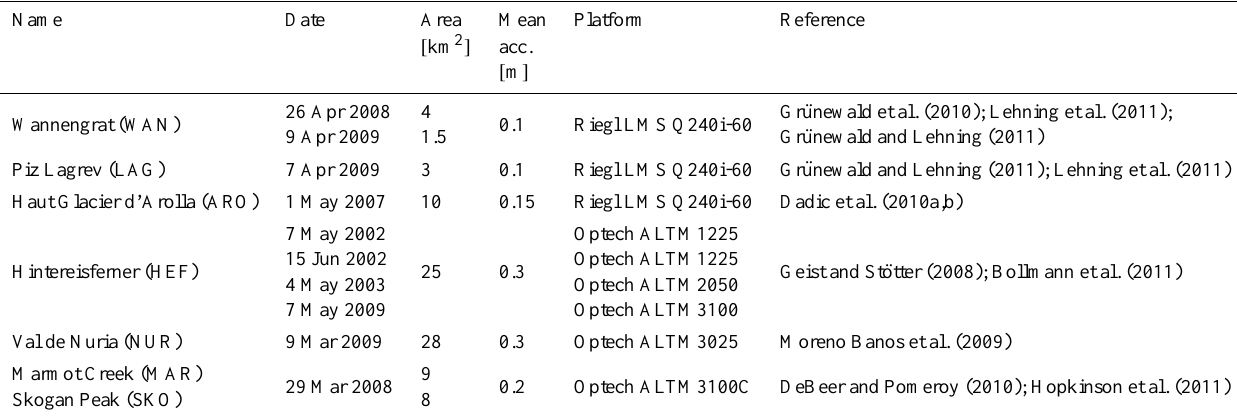
Table 1. Data sets. “Date” is the date of the winter survey, “Area” the area of the data set, “Mean acc.” the mean accuracy in vertical direction as quoted in the reference column and “Platform” the measurement